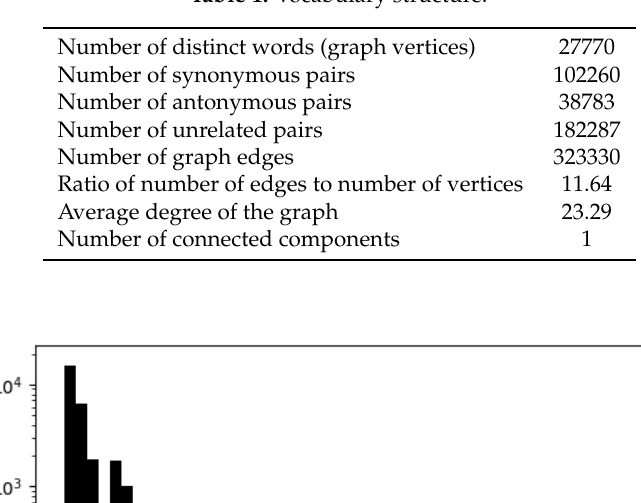
Table 1. Vocabulary structure.